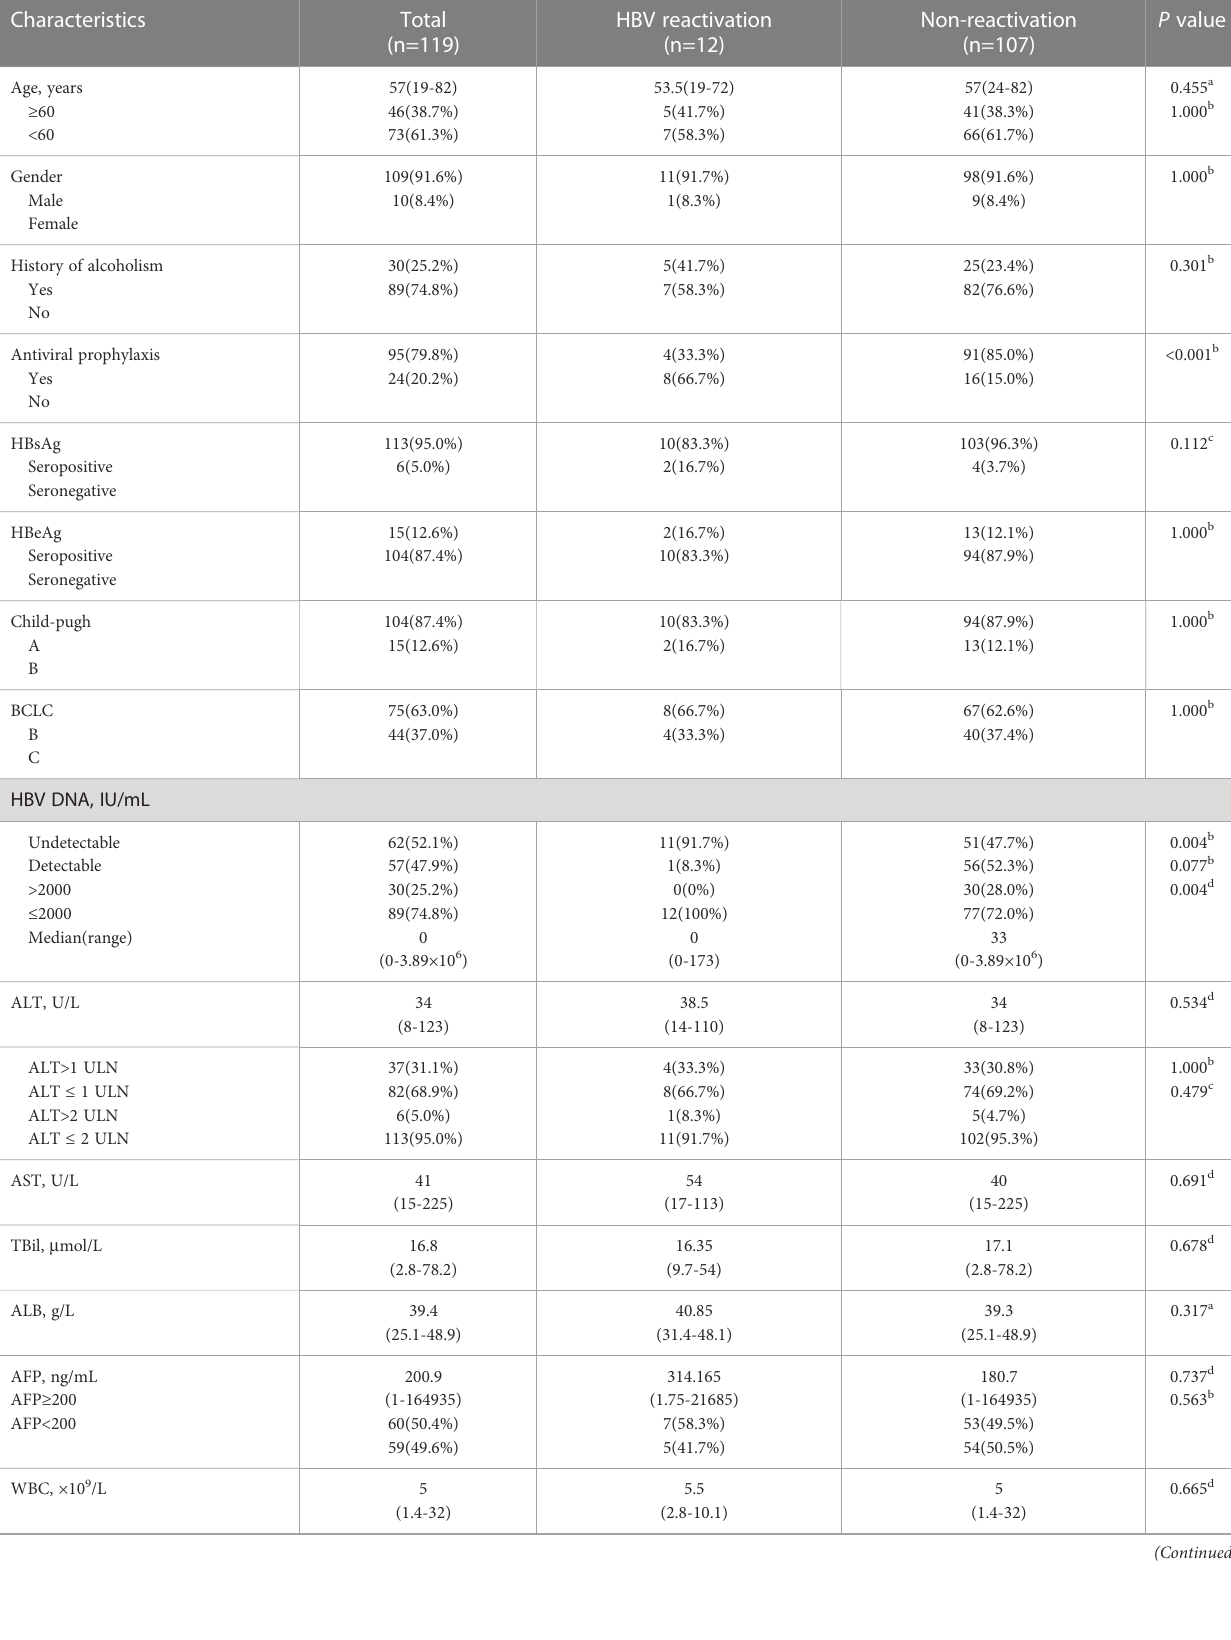
TABLE 1 Baseline characteristics of enrolled patients.